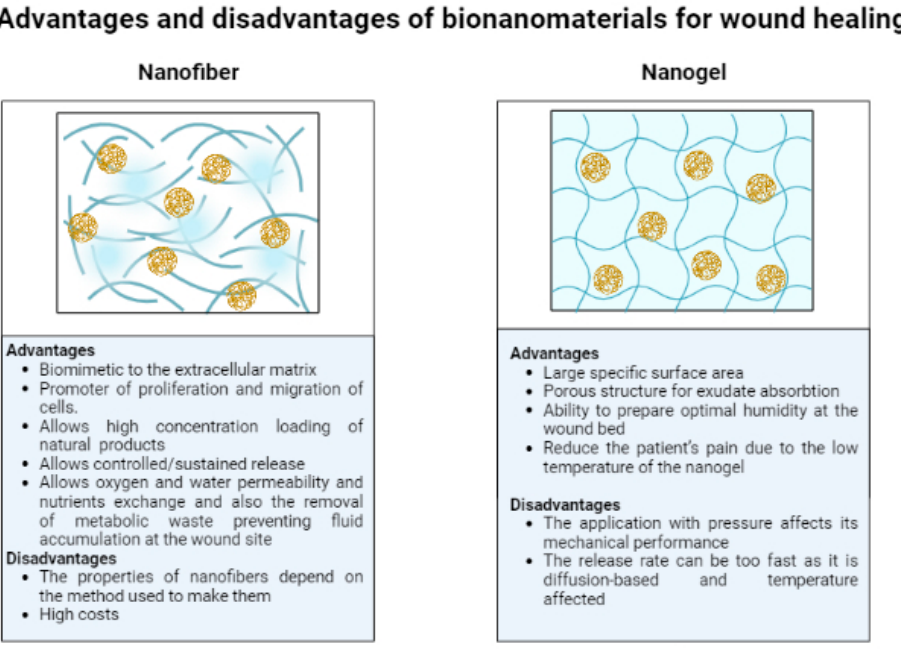
Figure 6. Advantages and disadvantages of the main bionanomaterials (nanofiber and nanogel) based on honey and propolis for wound healing [2,16,19,32,71–73,79,104–106]. Created by